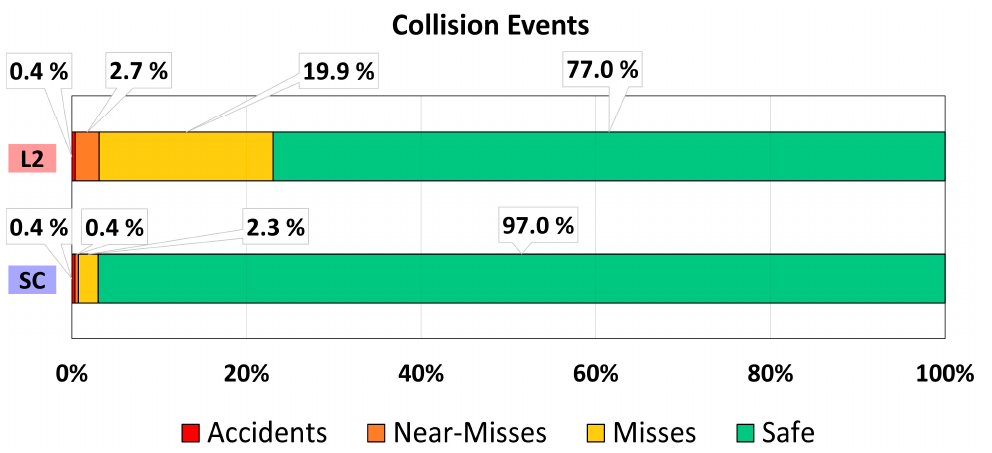
Figure 15. Analysis of collision-related events (TTC).